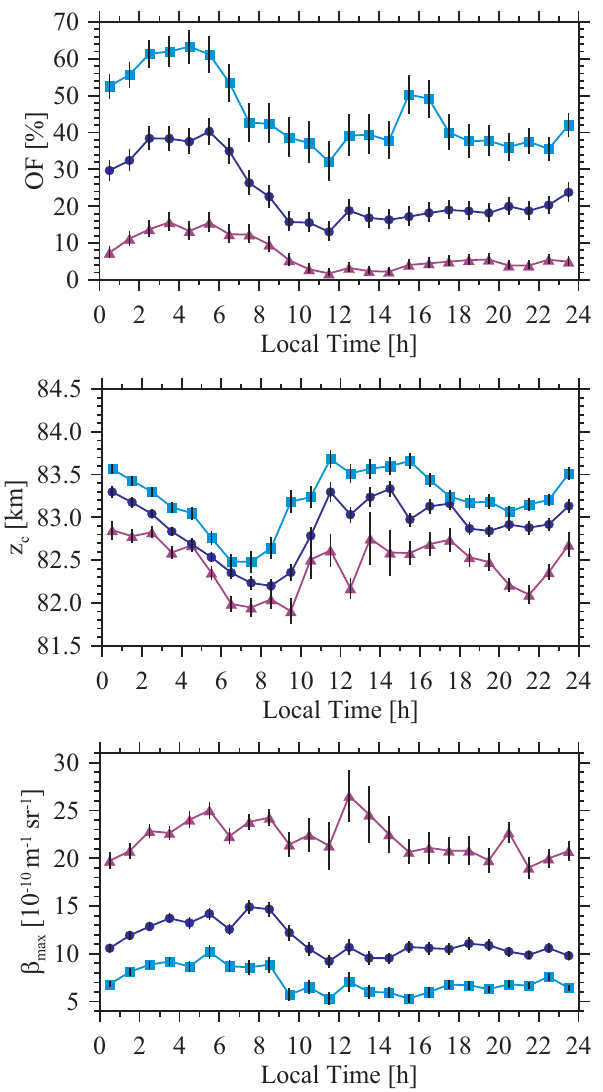
Fig. 4. Diurnal variation of NLC occurrence (top), altitude (mid- dle) and brightness (bottom) for the integrated data set from 1997 to 2010, sorted by brightness classes: β max > 1 (light blue squares), β max > 4 (blue circles), β max > 13 (purple triangles). Vertical bars indicate confidence limits for the occurrence at 95%-level and er- rors of the means for altitude and brightness.